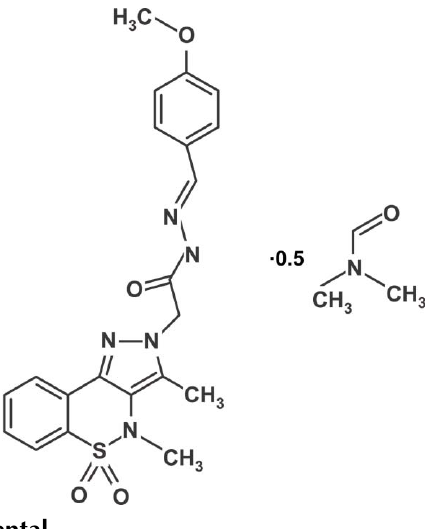
Acta Crystallographica Section